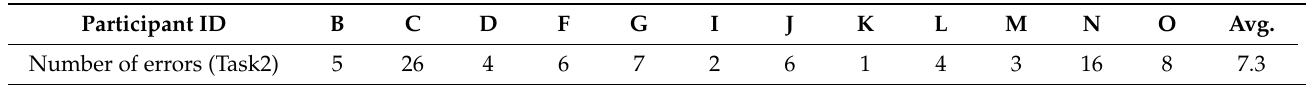
Table 6. Number of errors for each participant in Task2.